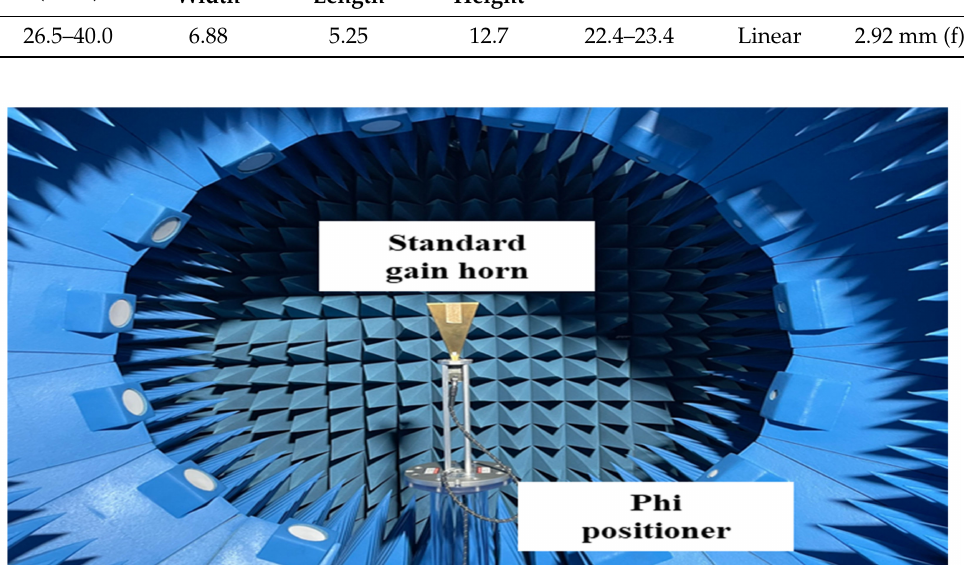
Figure 8. Photograph of measuring the standard-gain horn.